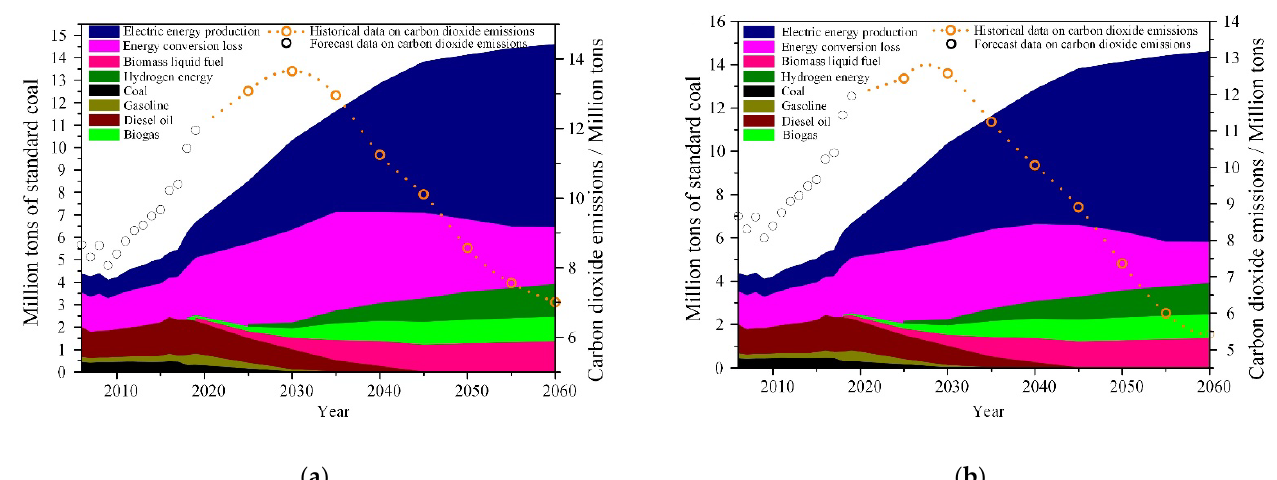
Figure 10. ( a ) Forecast under the base scenario; ( b ) Forecast under the radical model (From China Energy Statistics Yearbook (2007–2020) [14] and model calculation data from the State Grid Energy Research Institute.).